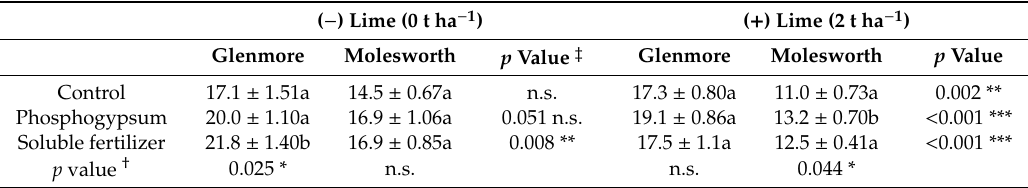
Table 6. Average soil Olsen P (mg kg − 1 ± SEM) measured after 6 months of phosphogypsum (PG), soluble fertilizer (PS) and lime application to two di ff erent soils (Glenmore and Molesworth). Within columns, means followed by the same lower-case letter are not significantly di ff erent (Dunnett test at 5%). Within rows, means were compared using a two-sample t -test at